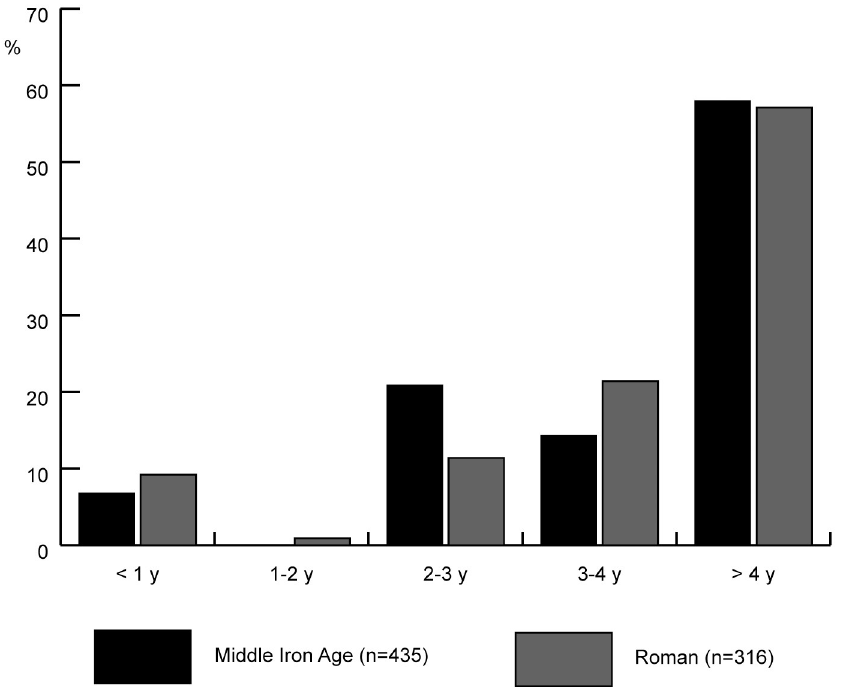
Fig 4. Mortality profile for cattle from Houten-Castellum, based on epiphyseal fusion.